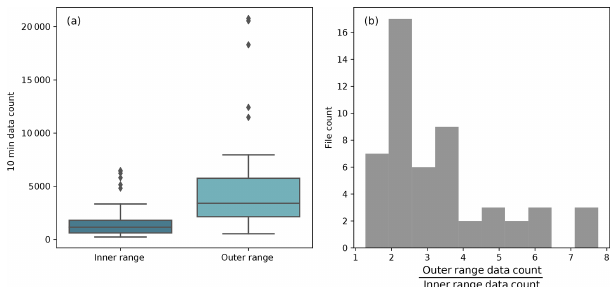
Figure 5. (a) Box plots of the 10min data count from the 52 normalized-mean-error-filtered (NME-filtered) submissions in the inner range (dark blue) and outer range (light blue). The box plot displays the lower whisker (lower quartile minus 1.5 times the in- terquartile range, which is the difference between the upper quartile and lower quartile), the lower quartile, the median, the upper quar- tile, the upper whisker (upper quartile plus 1.5 times the interquar- tile range), and outliers as black diamonds; (b) histogram of the ratio between the outer range data count and the inner range data count from the 52 NME-filtered